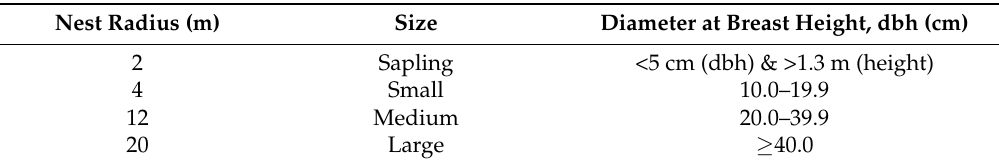
Table 2. Summary of living trees measurement in a plot.